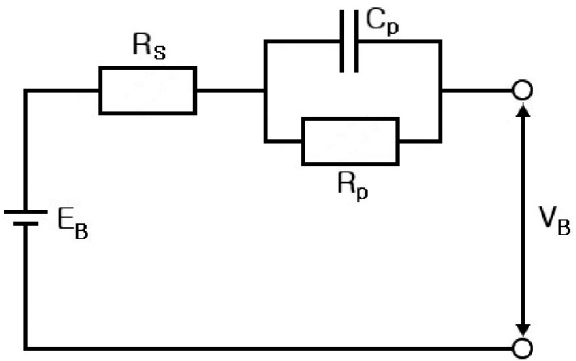
Figure 2. Thevenin battery model [1].